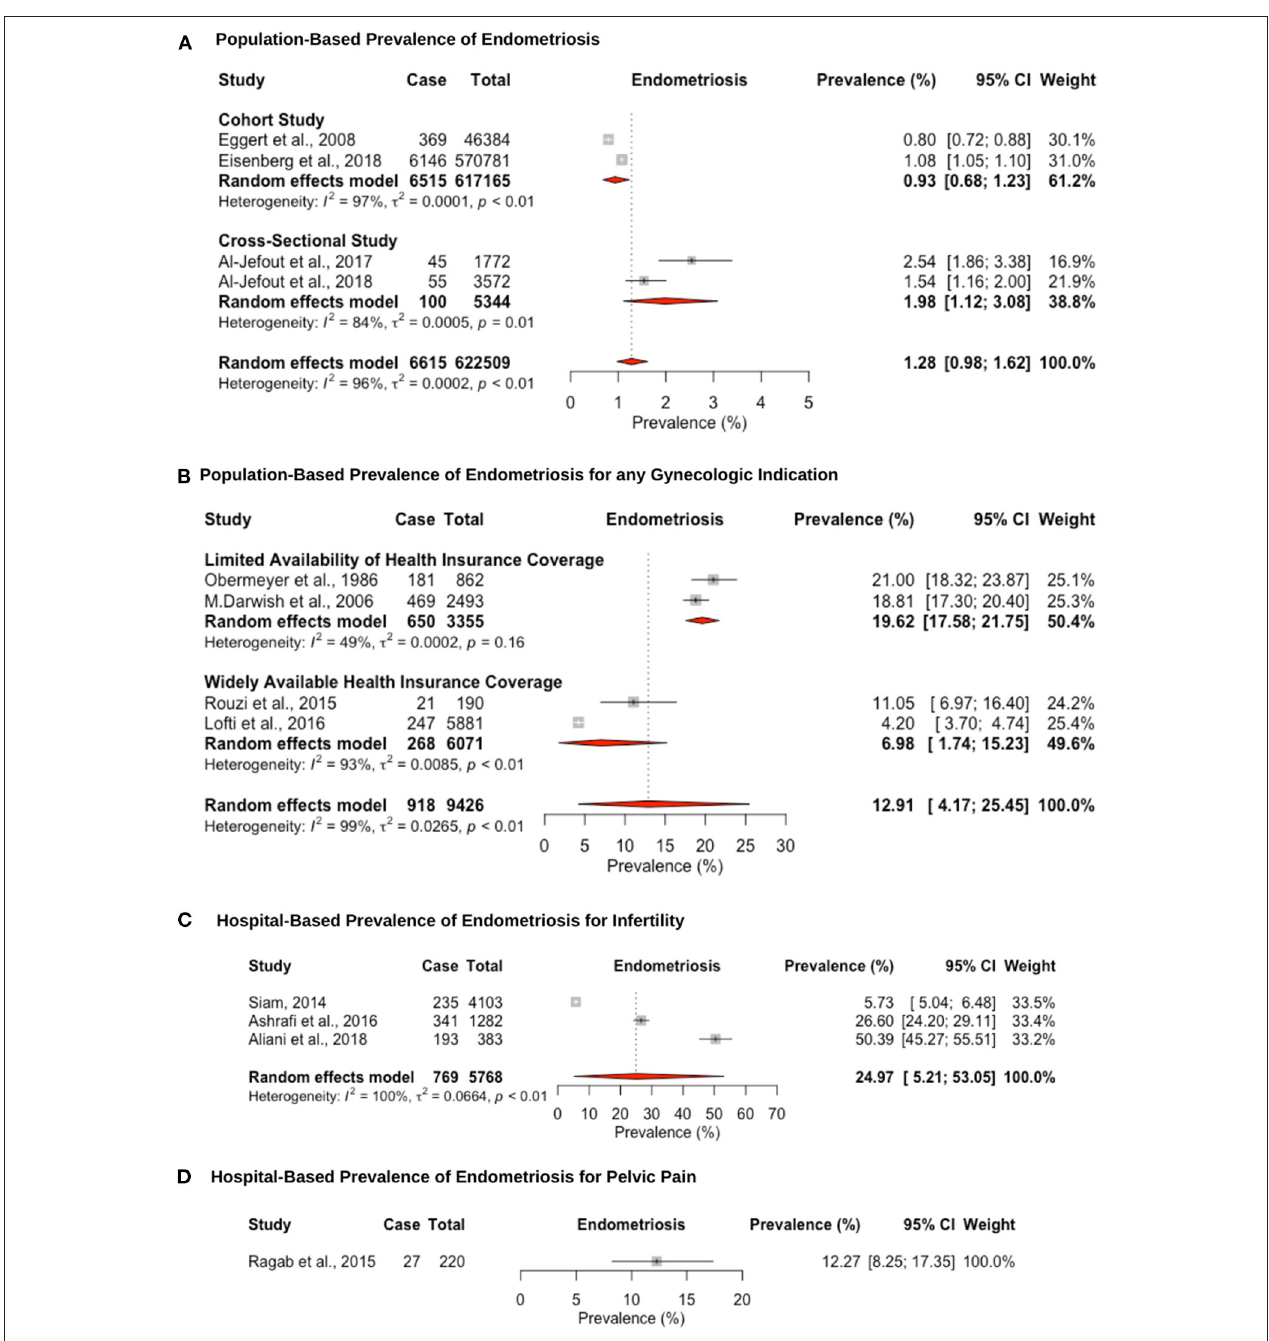
FIGURE 3 | Forest plot of the pooled prevalence estimate of surgically confirmed endometriosis: (A) population-based study, (B) hospital-based study (undergoing laparoscopy for any reason), (C) hospital-based study (presenting with infertility), and (D) hospital-based study (presenting with pelvic pain).